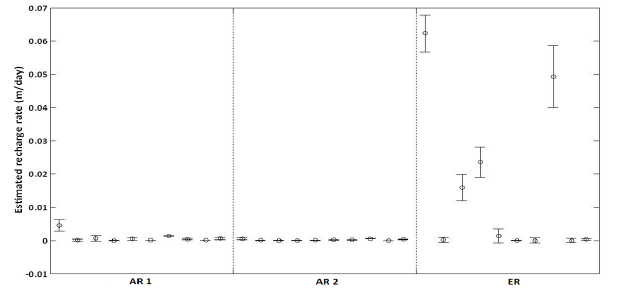
Fig. 8. Simultaneous confidence limits (upper and lower limits) on recharge rate estimated by 10 different unsteady-state groundwater flow model of three different recharge zones (AR 1, AR 2, and ER).